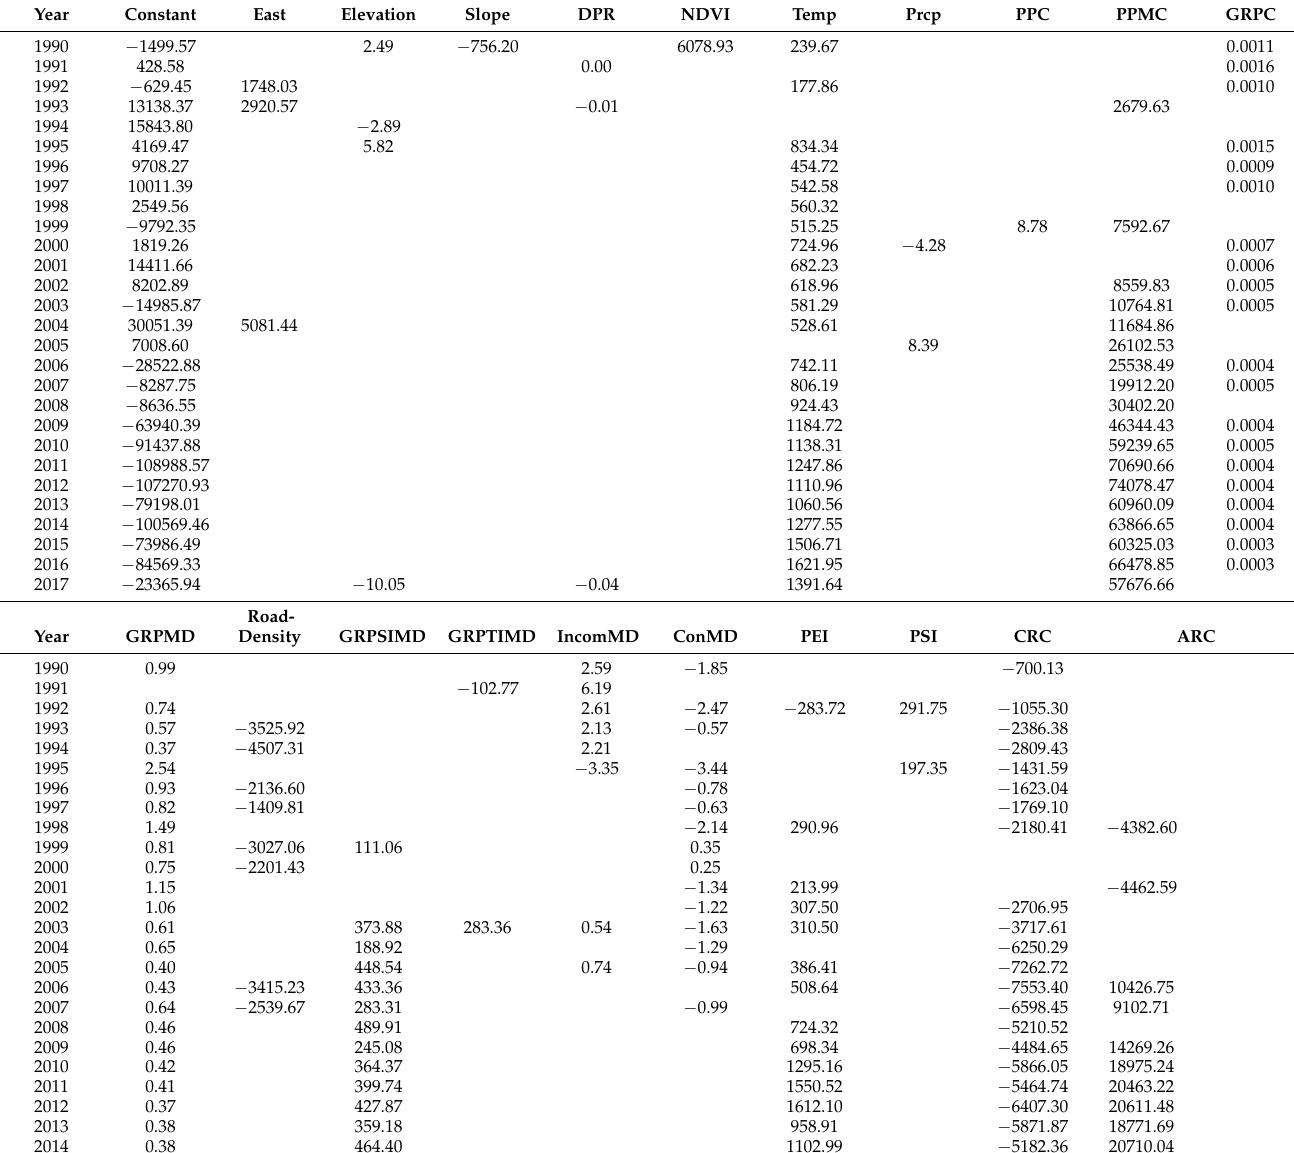
Table 6. Multiple linear regression models for temporal assessment (see Table 1 for